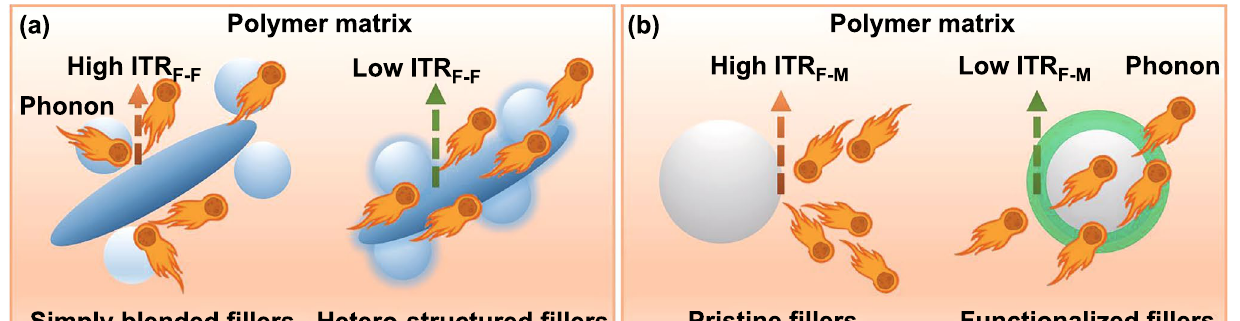
Fig. 1 Schematic diagram of perspective intrinsically thermally conductive polymers with ordered structures at both microscopic and macro- scopic levels